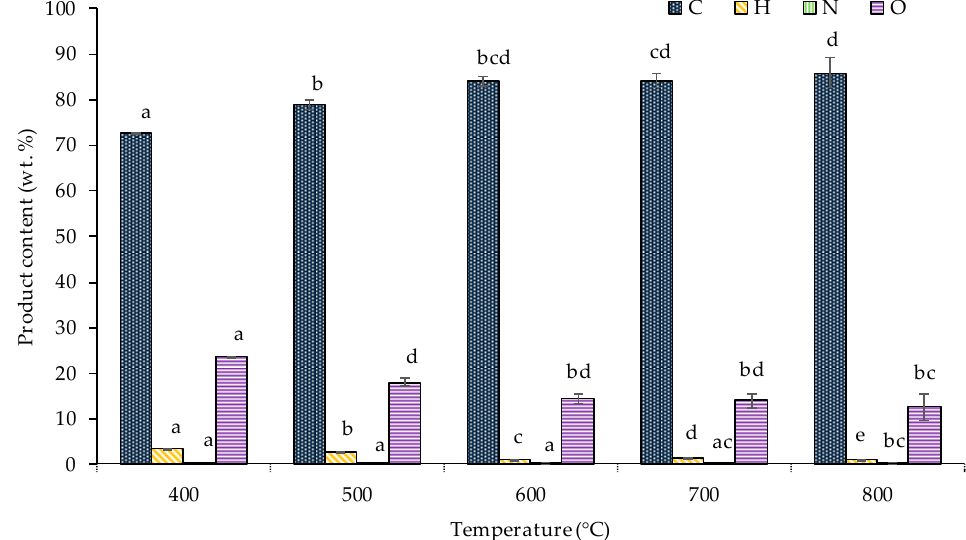
Figure 3. Effect of temperature on fundamental content of coconut shell bio-char against varying conditions of temperature, where each bar indicates the mean ± standard error [ SE ( n = 3)]. Note: distinct letters in each specific yield bar indicate significant differences ( p ≤ 0.05).